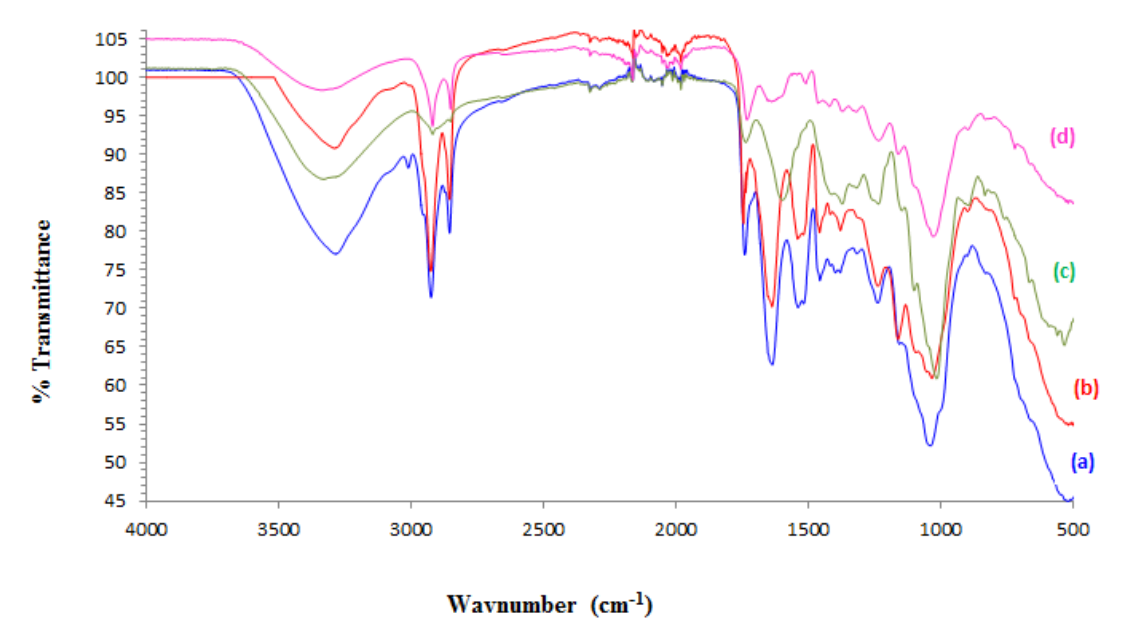
Figure 2. FT-IR spectra of ( a ) CCSs pre- adsorption, ( b ) CCSs post adsorption, ( c ) CCPs pre- adsorption and ( d ) CCPs post adsorption. Table 1. FT-IR band position (cm − 1 ) and function groups assignments of CCSs and CCPs before and after adsorption.